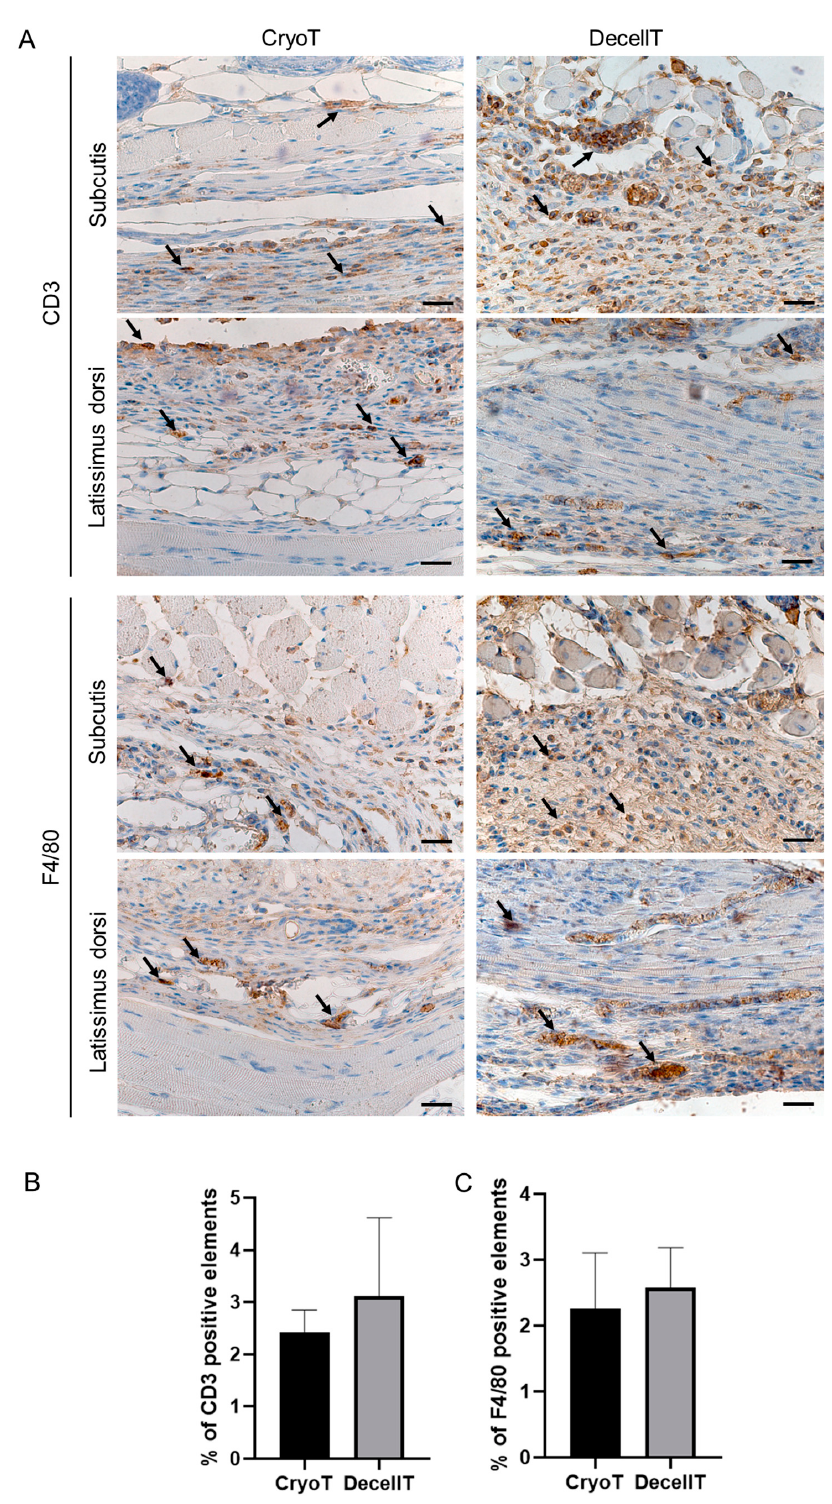
Figure 16. ( A ) Immunohistochemical characterization of cryopreserved (CryoT) and decellularized (DecellT) samples after heterotopic positioning in Balb/C mice subcutaneous pouch and retrieval at day 14 from surgery. The immunolocalization of CD3+ and F4/80+ cells (dotted brown-stained elements, black arrows) at the boundaries between the tracheal specimens and the host tissues showed the presence of a mild lympho-monocytic infiltration triggered by the scaffolds. Scale bars: 25 µ m. Quantification of CD3 and F4/80 positive elements ( B , C ) within the CryoT and DecellT samples, after retrieval. No significant difference was